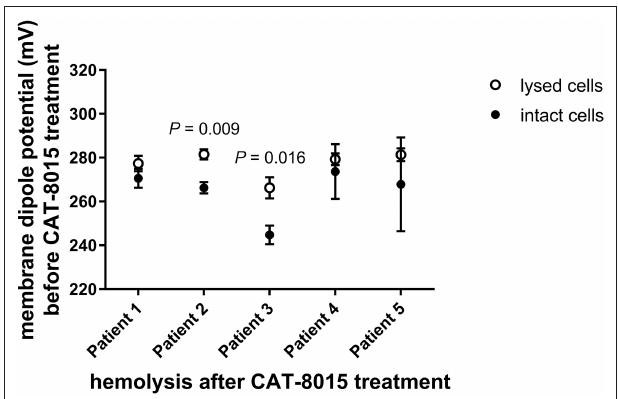
FIGURE 4 | Differences in the MDP of individual cells within a population of RBCs are correlated with their susceptibility to CAT-8015-induced haemolysis. Average ( ± SEM) MDP values of a population of RBCs from pediatric ALL patients ( n = 5) before CAT-8015 treatment. Intact cells refer to RBCs that were resistant to CAT-8015-induced lysis while lysed cells refer to RBCs that were sensitive to CAT-8015-induced lysis. Significant differences are indicated. Statistical significance was determined using Holm-Sidak method, with alpha = 0.05, multiple t -tests, one unpaired t -test per row. At least 20 cells per treatment were